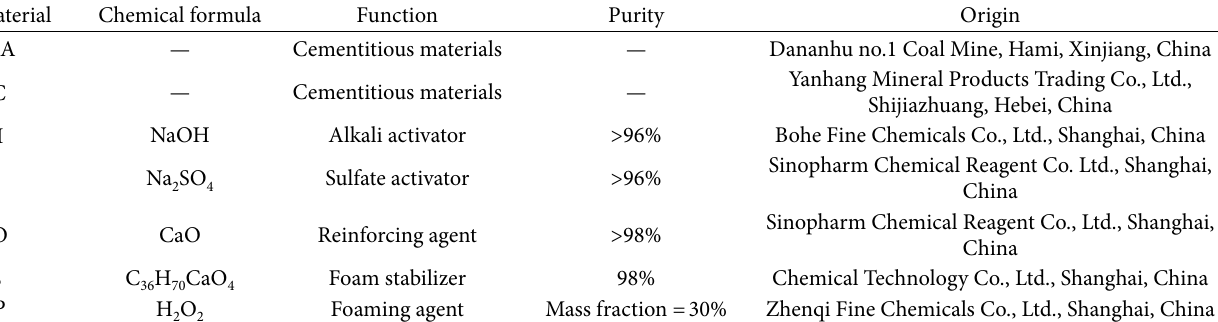
Table 2: Raw materials for FAFG.